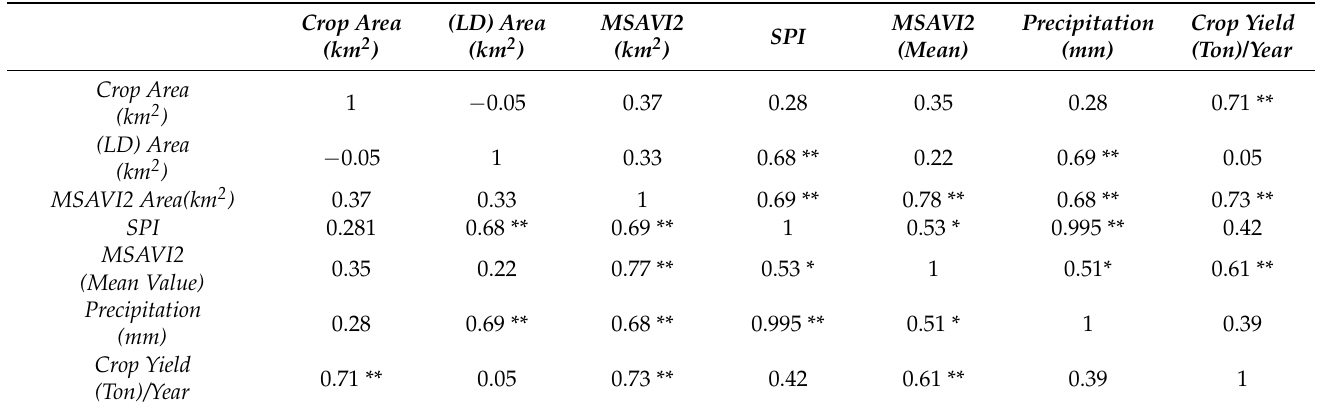
Table 6. Correlation coefficients between spectral indices, meteorological indices crop area, crop yield, and annual average